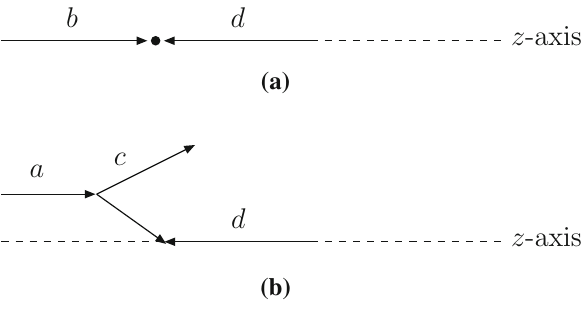
Fig. 5 ISR kinematics. a Before branching: partons b and d incoming in the ± z direction. b After the branching a → b + c , now with a and d are along the z